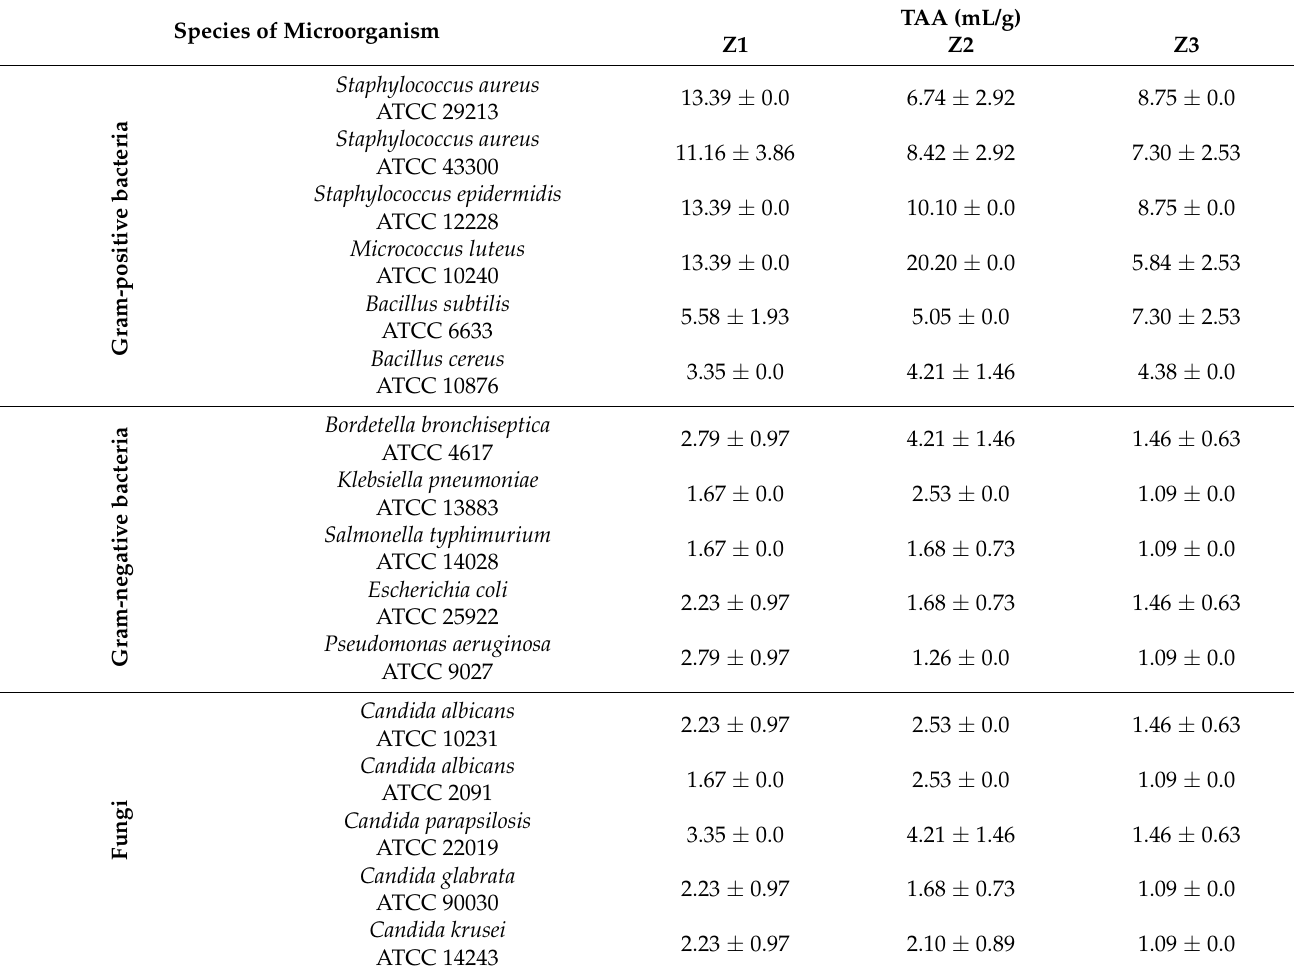
Table 4. The activity data of Z. bungeana extracts expressed as TAA (Total Antibacterial Activity or Total Antifungal Activity) [mL/g] against the reference strains of bacteria and fungi.